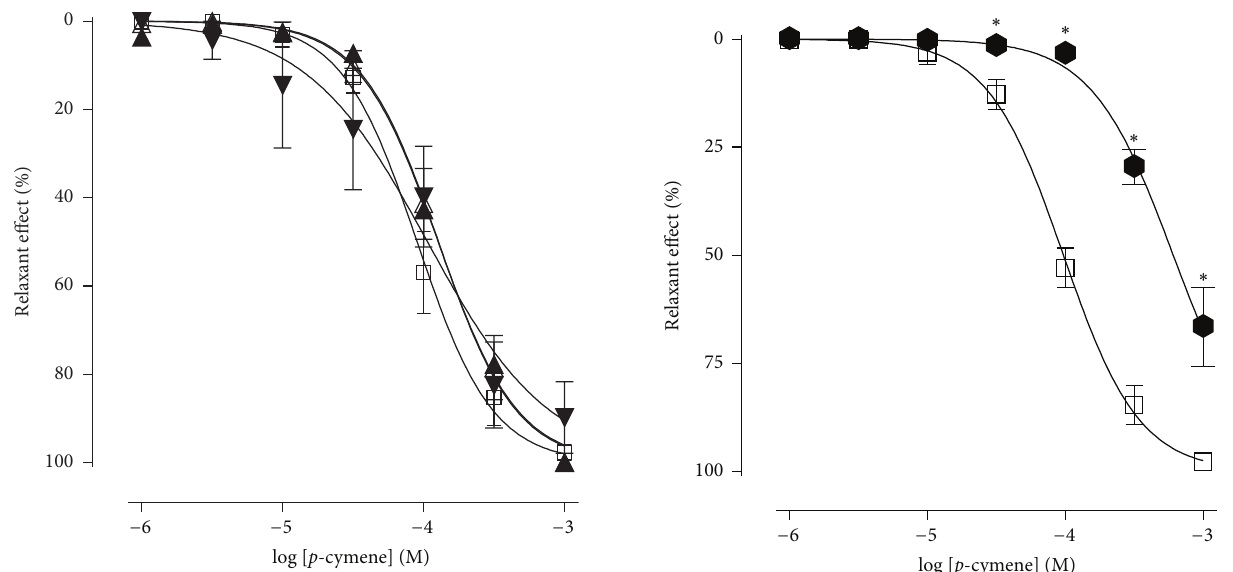
Figure 7: Relaxant effect of p -cymene on the isolated rat aortic rings without endothelium, contracted by phenylephrine, in the absence ( ◻ ) and presence of glibenclamide 3 𝜇 M ( C ). ∗ 𝑃 < 0.05 (unpaired 𝑡 -test: absence × presence of